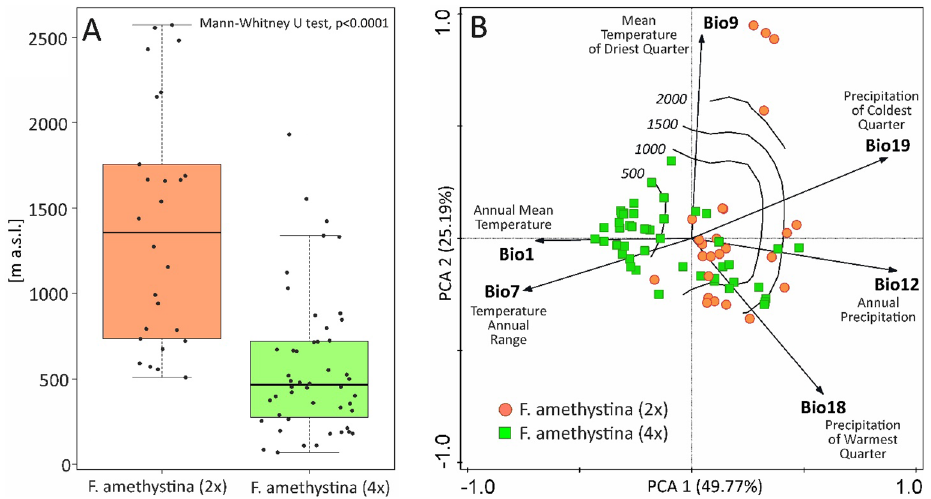
Figure 3. Localities of F. amethystina cytotypes according to altitude ( A ) and in PCA multidimensional climatic space ( B ). Boxplots in panel ( A ): the solid lines represent the median, the ends of the boxes indicate upper and lower quartiles, the whiskers show the highest and lowest value excluding outliers, the black dots show the distribution of all localities. Panel ( B ): contours with values corresponding to the altitude [m] estimated by Generalized Additive Model (GAM) according to the PCA axes.